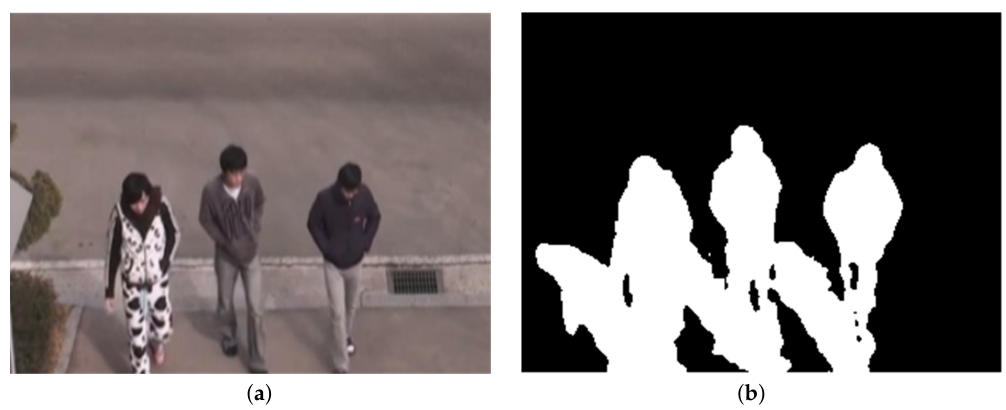
Figure 2. Foreground region extracted in a video content analytics algorithm: ( a ) Input video frame; ( b ) Foreground region